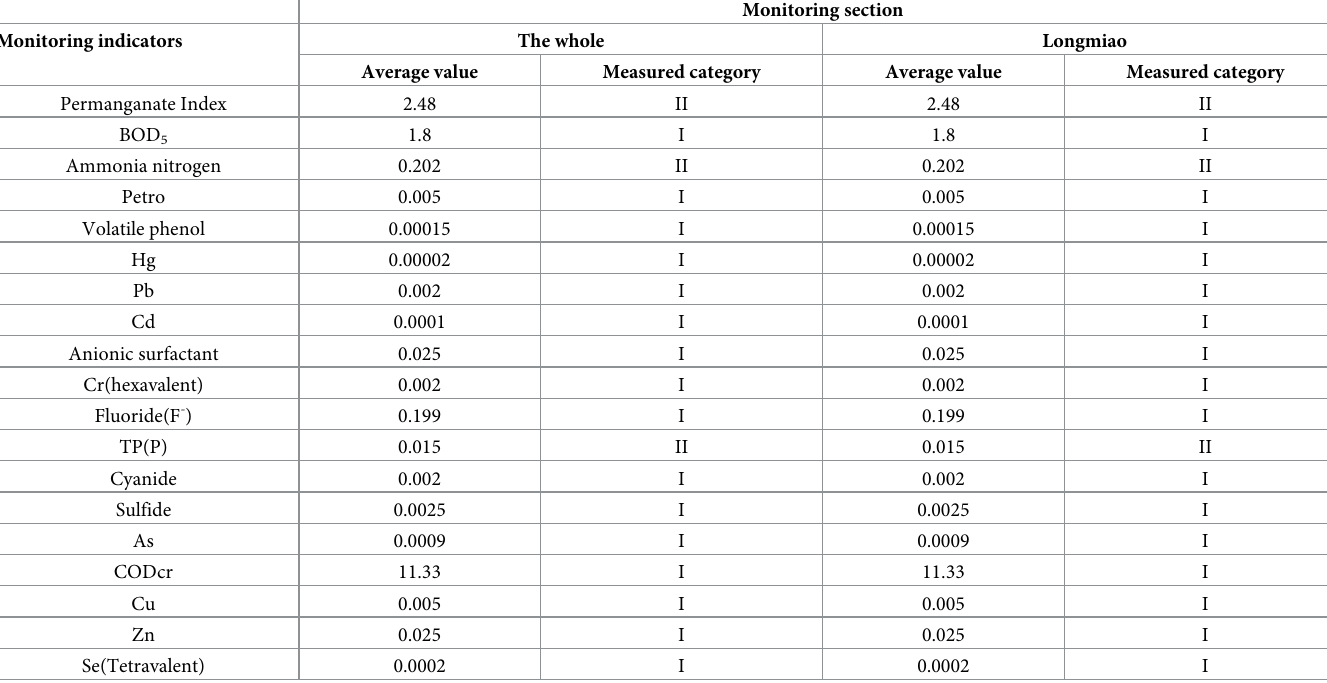
Table 5. Statistical results of various indicators in Heilongtan Reservoir in 2021.